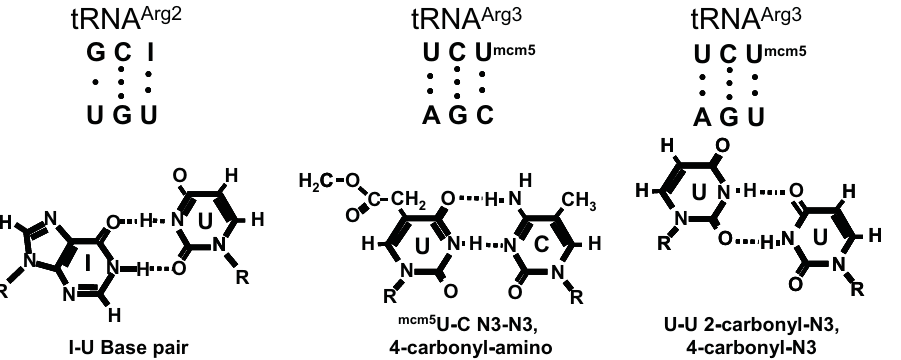
Figure 2. Proposed basis for near-cognate codon-anticodon interactions. Top. Base pairing between tRNA Arg2 anticodon and UGU codon (left), and between tRNA Arg3 anticodon and the AGC and AGU codons. Bottom. I N U, U N C, and U N U base pairing.